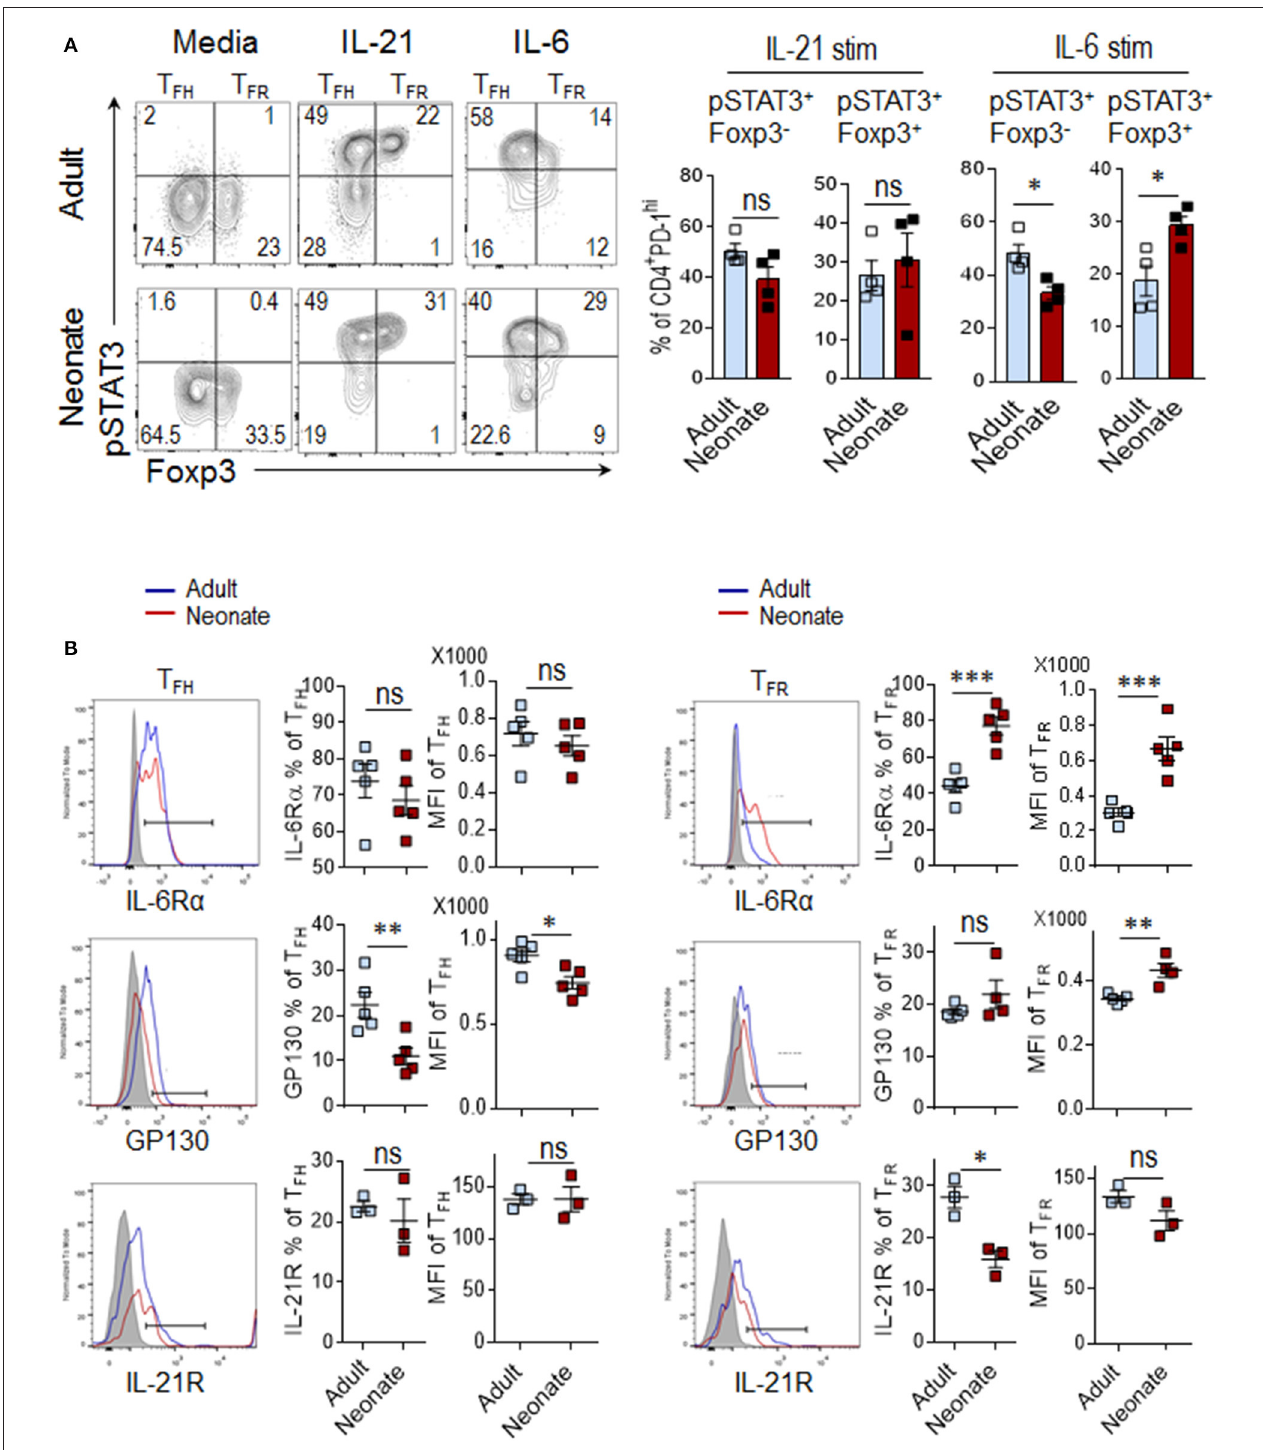
FIGURE 3 | IL-6 signaling preferentially induces T FR differentiation in neonatal mice. Adult (6 to 10-week-old) and neonatal (5 day-old) mice were immunized i.p. with SRBC, and STAT3 activity in splenic CD4 + cells was analyzed in flow cytometry at 5 dpi. (A) For phospho-STAT3 activity measurement, splenocytes were stimulated with IL-21 (50ng/ml) or IL-6 (100ng/ml) for 15min, followed by phospho-flow staining. Plots showing the percentage of pSTAT3 + cells among Foxp3 + or Foxp3 − populations were pre-gated on CD4 + PD-1 hi cells ( Supplementary Figure 2 ). (B) Analysis of IL-6R α , GP130, and IL-21R expression on T FH and T FR populations. Cells in histograms were pre-gated on CD4 + CXC5 + PD-1 + Foxp3 − T FH and CD4 + CXC5 + PD-1 + Foxp3 + T FR cells as shown in Figure 1A . One out of three experiments with similar results is shown. Error bar, s.e.m.. * p < 0.05, ** p < 0.01, *** p < 0.001. Stim, stimulation.